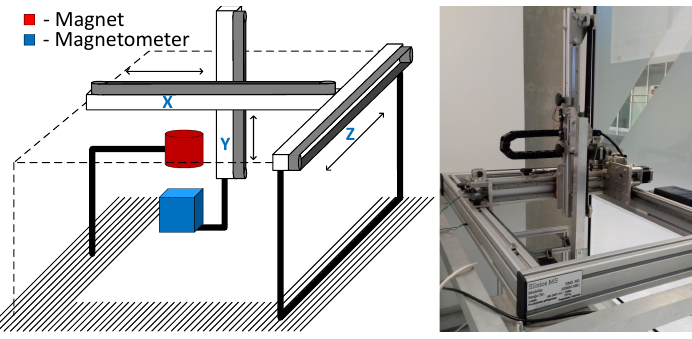
Figure 4. Experimental setup ( left ), and 3D positioning system “EMS 301” ( right ).